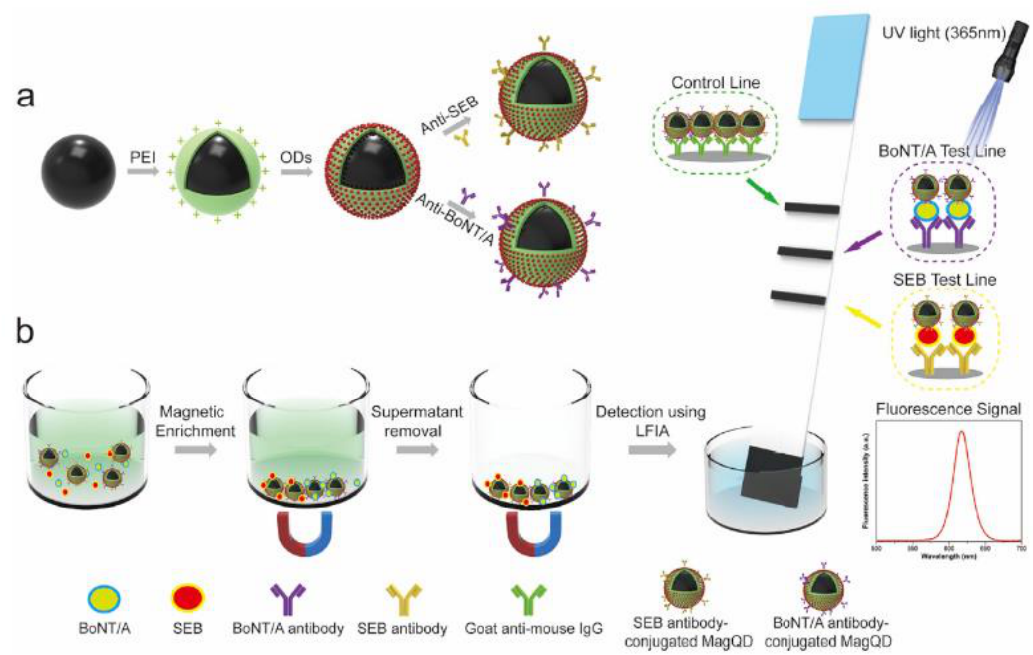
Figure 4. ( a ) Scheme of antibody (Ab)-modified magnetic-quantum dots (m-QDs) preparation and ( b ) mechanism of m-QDs-based lateral flow immunoassay (LFIA) strip for simultaneous and sensitive detection of two protein toxins. Reprinted from [66] with permission from Elsevier, 2020.